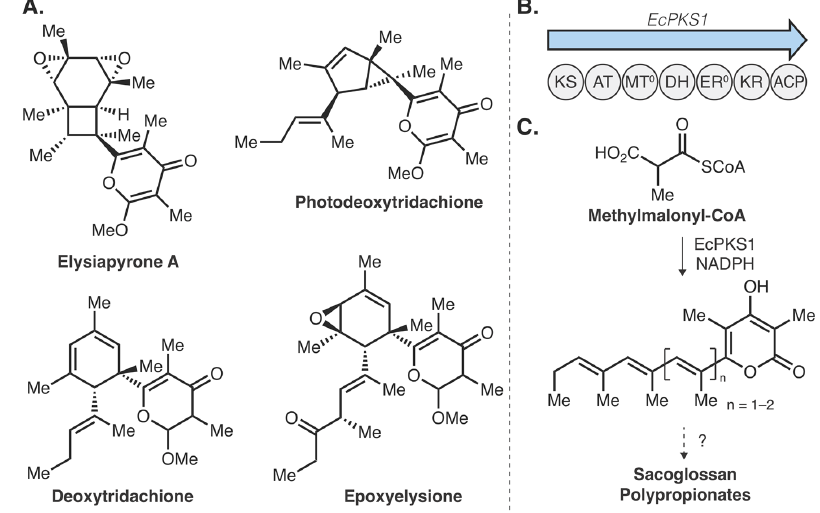
Figure 5. Sacoglossan sea slug polyproionate biosynthesis. ( A ) Representative structures of four polypropionates from Elysia spp. ( B ) Polypropionate synthase in Elysia chlorotica ( EcPKS1 ) and its domain architecture. ( C ) In vitro reconstitution of EcPKS1 with methylmalonyl ‐ CoA and NADPH